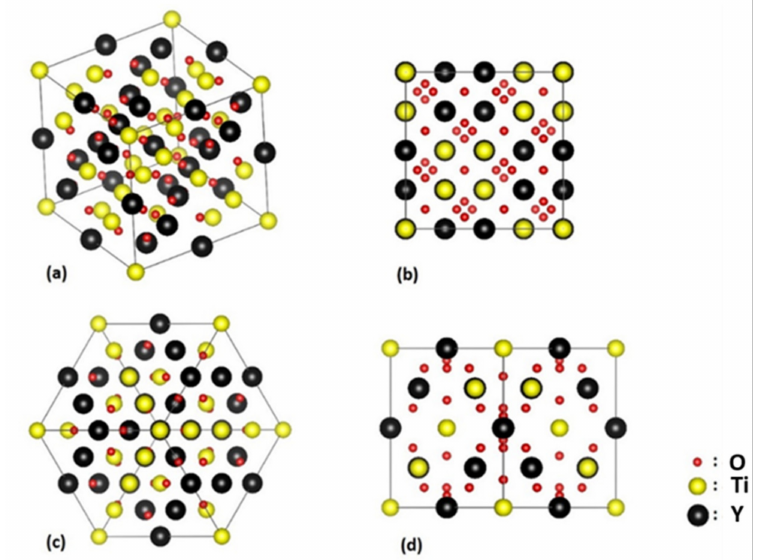
Figure 7. Pyrochlore-type lattice structure: ( a ) general view, ( b ) observed along the ( 001 ) direction, ( c ) observed along the ( 111 ) direction, ( d ) observed along the ( 011 )